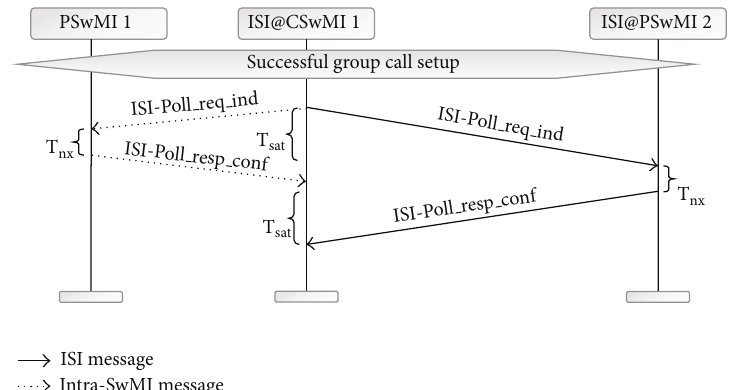
Figure 7: Information flow sequence, acknowledged group